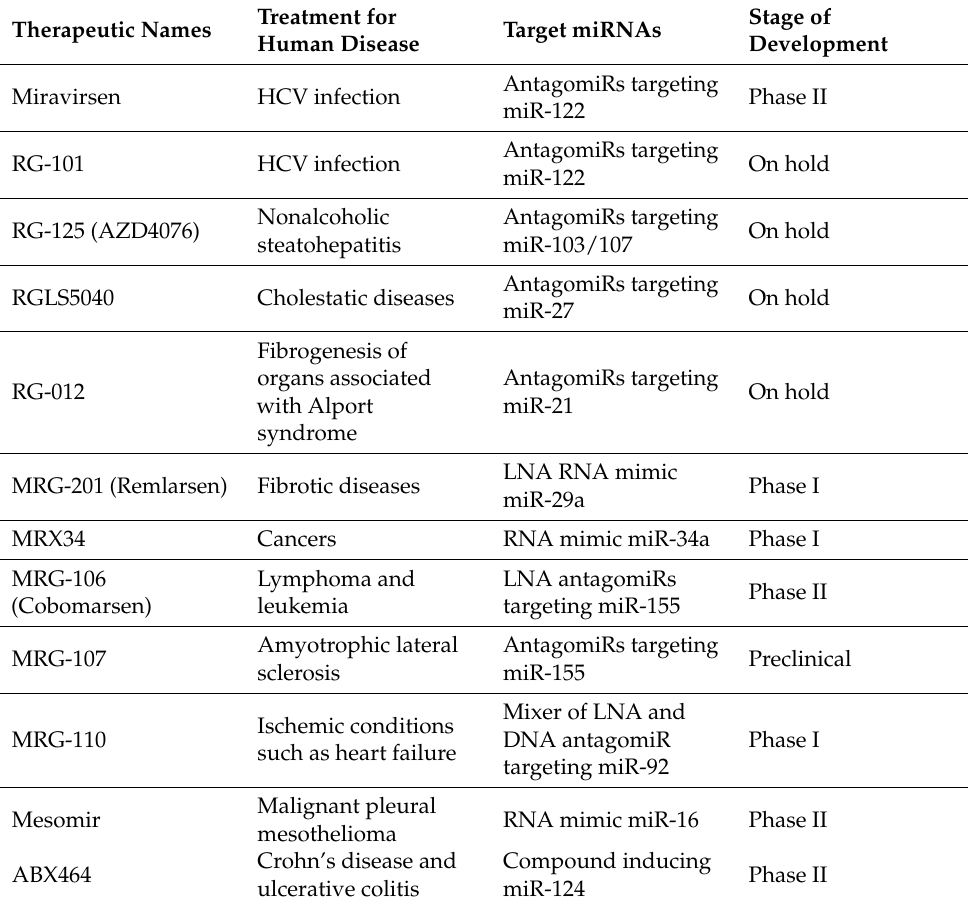
Table 2. MicroRNA based therapies for the treatment of human diseases and their stages of